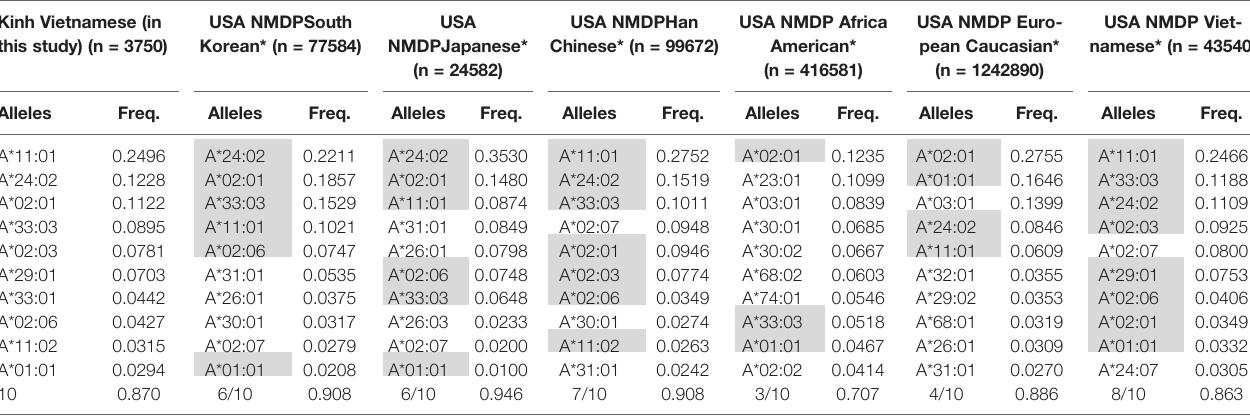
TABLE 6 | Distribution of the ten most frequent HLA-A alleles in seven populations. Kinh Vietnamese (in this study) (n =